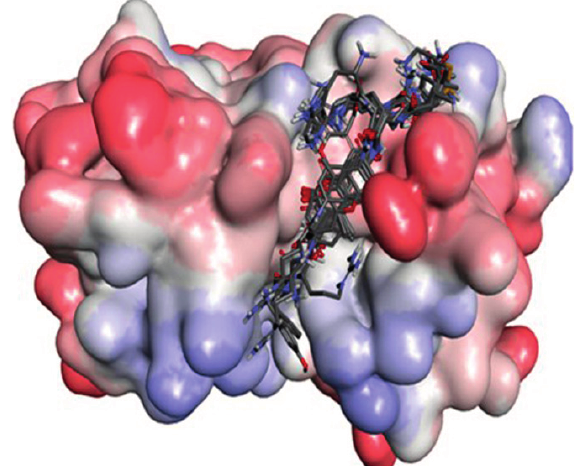
Figure 8. The protein contact potential of zmCP1–ligands complex. Red color represents negative charge; blue represents positive charge; and grey color represents neutral